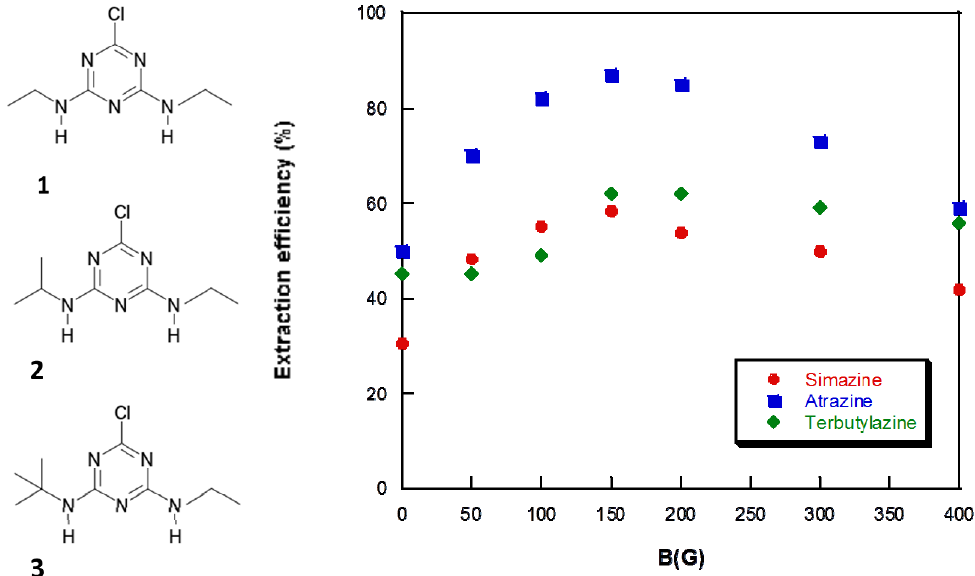
Figure 2. Variation of the extraction efficiency as function of the magnetic field for ( 1 ) simazine; ( 2 ) atrazine; and ( 3 ) terbutylazine. Injection 100 μ L of a mixture of the target analytes (30 μ g L − 1 ). Mobile phase: methanol:water 85:15, flow 6 μ L min − 1 . B = B (reverse adsorption desorption